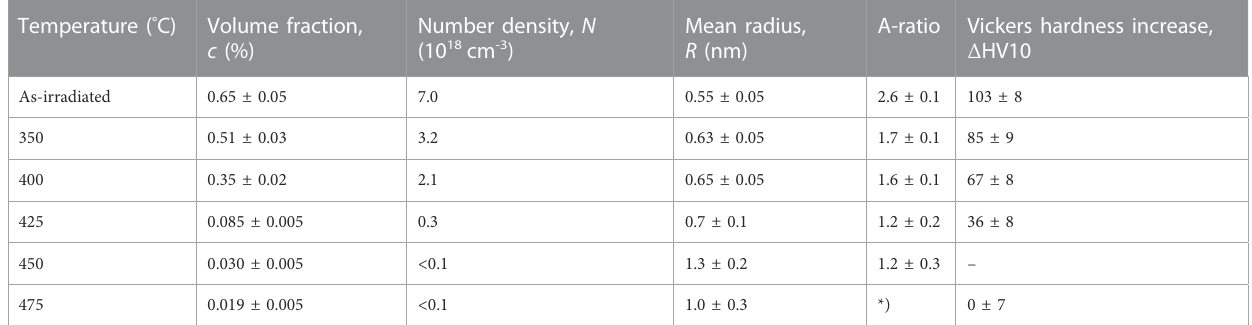
TABLE 2 Total volume fraction, total number density, mean radius and A-Ratio of the irradiation-induced scatterers as well as increase of the Vickers hardness Δ HV10 obtained for as-irradiated and post-irradiation annealed samples of VVER-1000 weld. Temperature ( ° C)